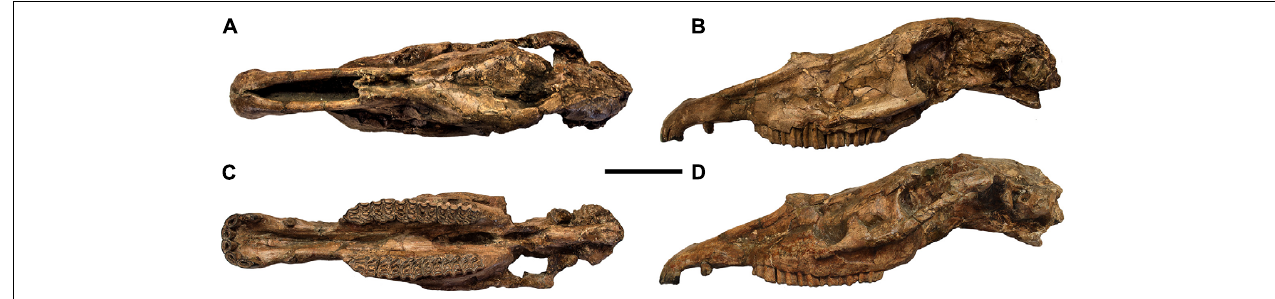
FIGURE 1 | Equus stenonis IGF560 holotype, housed in the Geological and Paleontological section of the Natural History Museum of Florence. (A) Dorsal view; (B) lateral view, left side; (C) ventral view; (D) lateral view, right side reflected. Scale bar 10 cm.